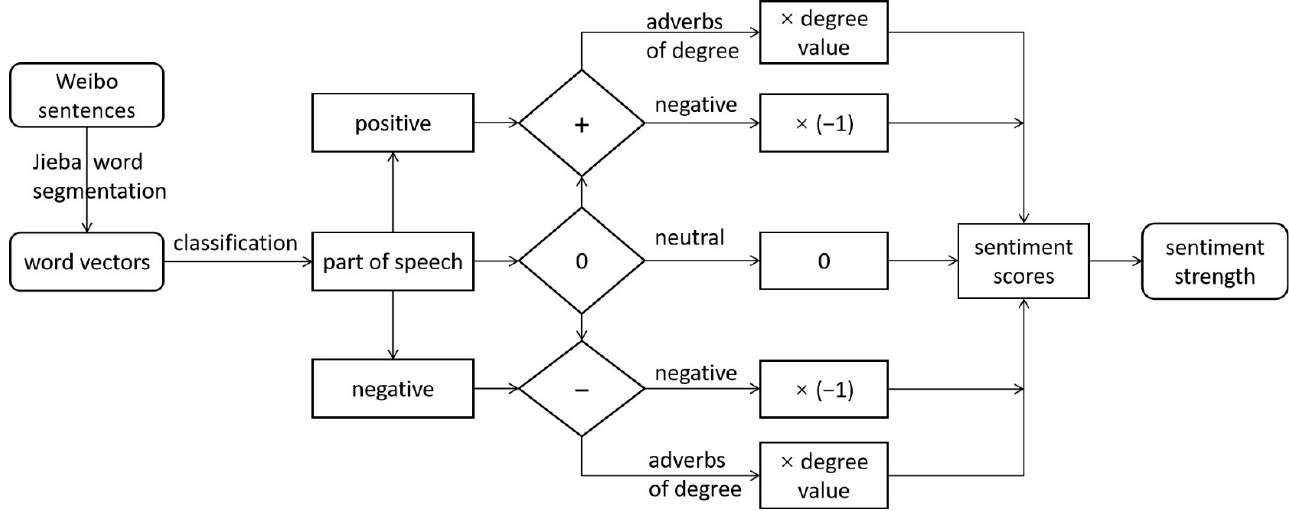
Figure 3. Dictionary-based sentiment analysis (DSA).